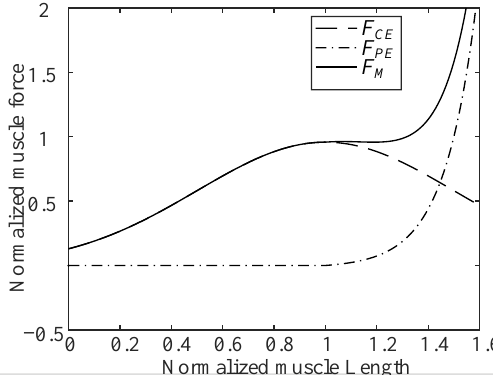
Figure 2. Schematic diagram of muscle force composition.